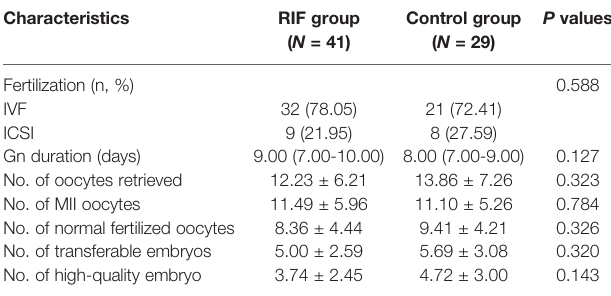
TABLE 2 | Controlled ovarian hyperstimulation and laboratory indicators. Characteristics